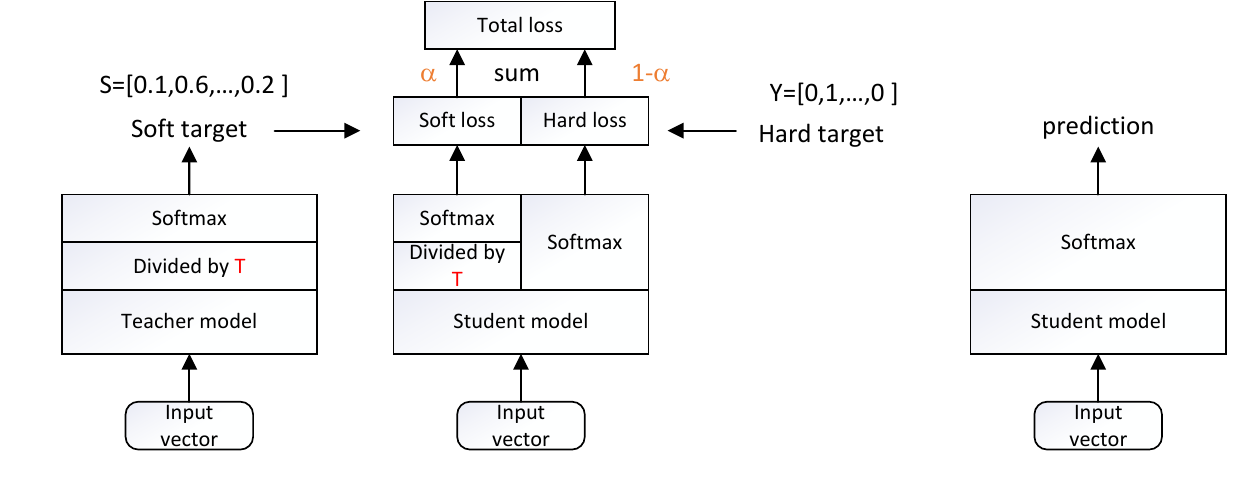
Figure 12. The process of knowledge